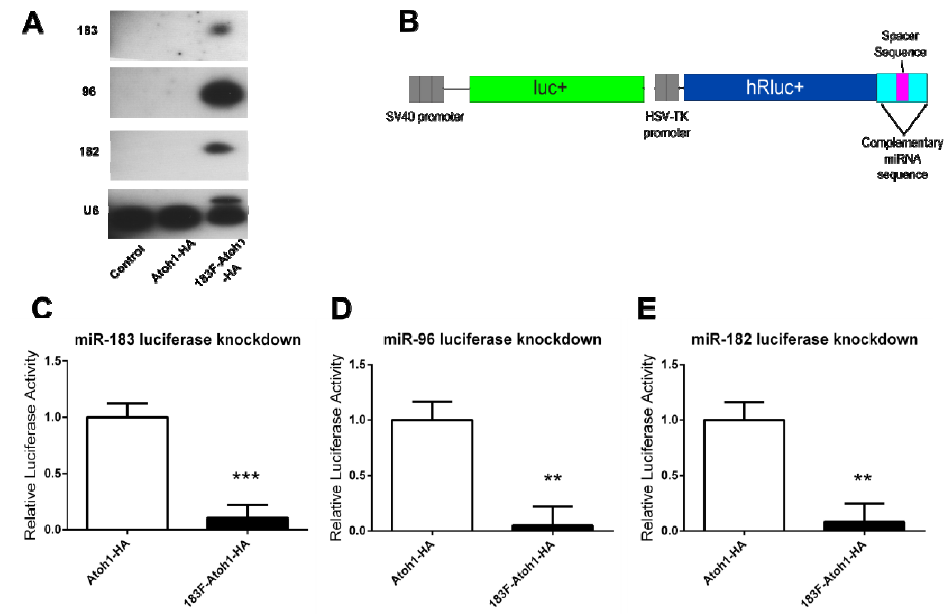
Figure 4. miRNAs are expressed from the 183F-Atoh1-HA vector and functional. ( A ) p183F-Atoh1-HA transfection leads to production of mature miR-183 family members. Untransfected HEK293T cells and cells transfected with pAtoh1-HA show no detectable expression of 183 family members; whereas miR-183, -96, and -182 are each detected in cells transfected with p183F-Atoh1-HA. U6 levels are provided as the loading control; ( B ) Illustration of miRNA-specific reporter plasmids. PsiCHECK-2 luciferase reporters contain 2 sites complementary to miR-96, -182, or -183 in the 3'UTR; ( C – E ) Knockdown of luciferase activity in reporters specific to each member of the miR-183 family; ( C ) Cells co-transfected with reporter containing miR-183 sites and p183F-Atoh1-HA showed a marked decrease in luciferase activity compared to wells transfected with the miR-183 reporter and pAtoh1-HA. Experiments in ( D ) and ( E ) were conducted in the same manner except with miR-96 or miR-182 complementary binding sites in the luciferase reporter. All showed significant decrease in luminescence. Each bar represents mean (±standard error) for each group. Each experiment was replicated at least three times. * p < 0.05, ** p < 0.005, *** p <